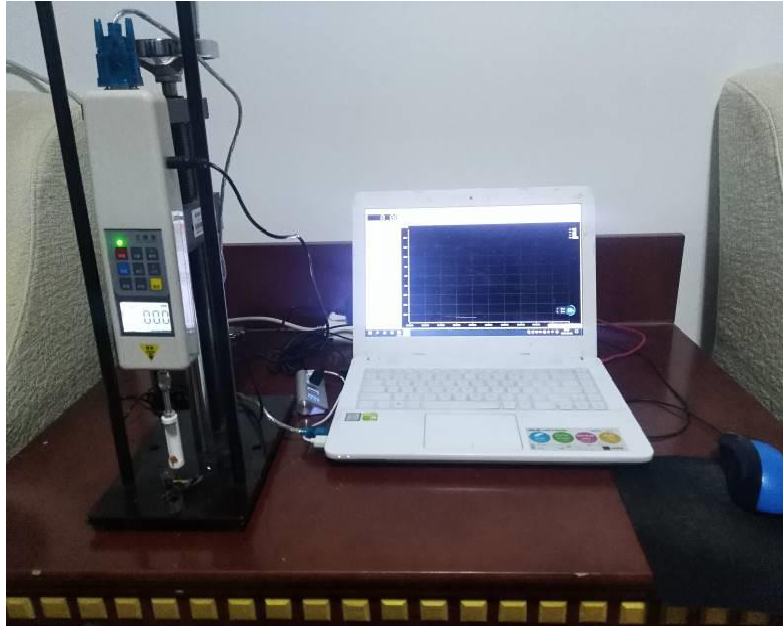
Figure 8. The measuring device of picking forces.